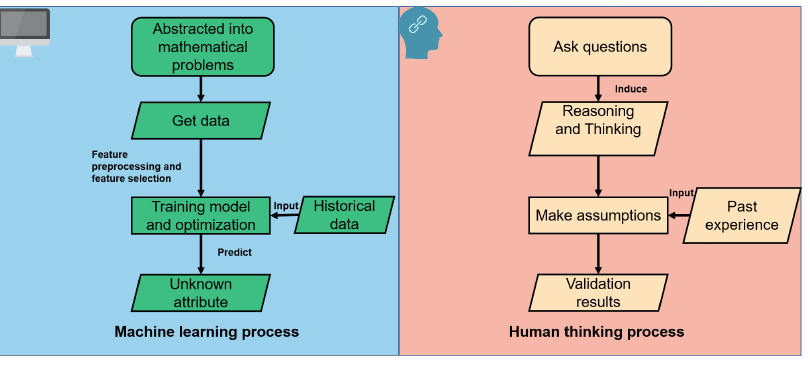
Figure 1. Comparison of ML and human thought